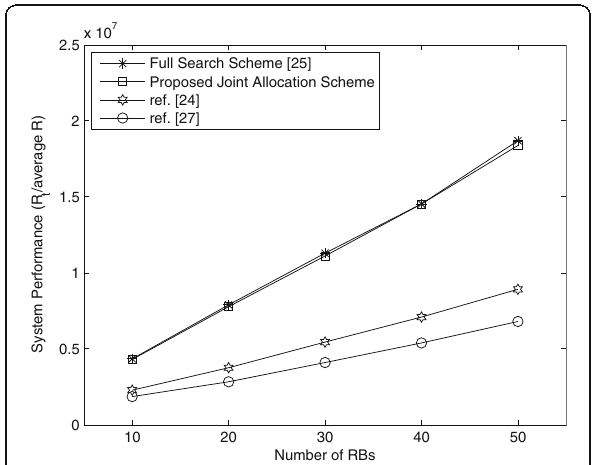
Fig. 5 Comparison of the proposed joint allocation scheme with the existing schemes. The value of the objective function versus the number of RBs with the number of UEs K = 24 and the bias value = 8 dB